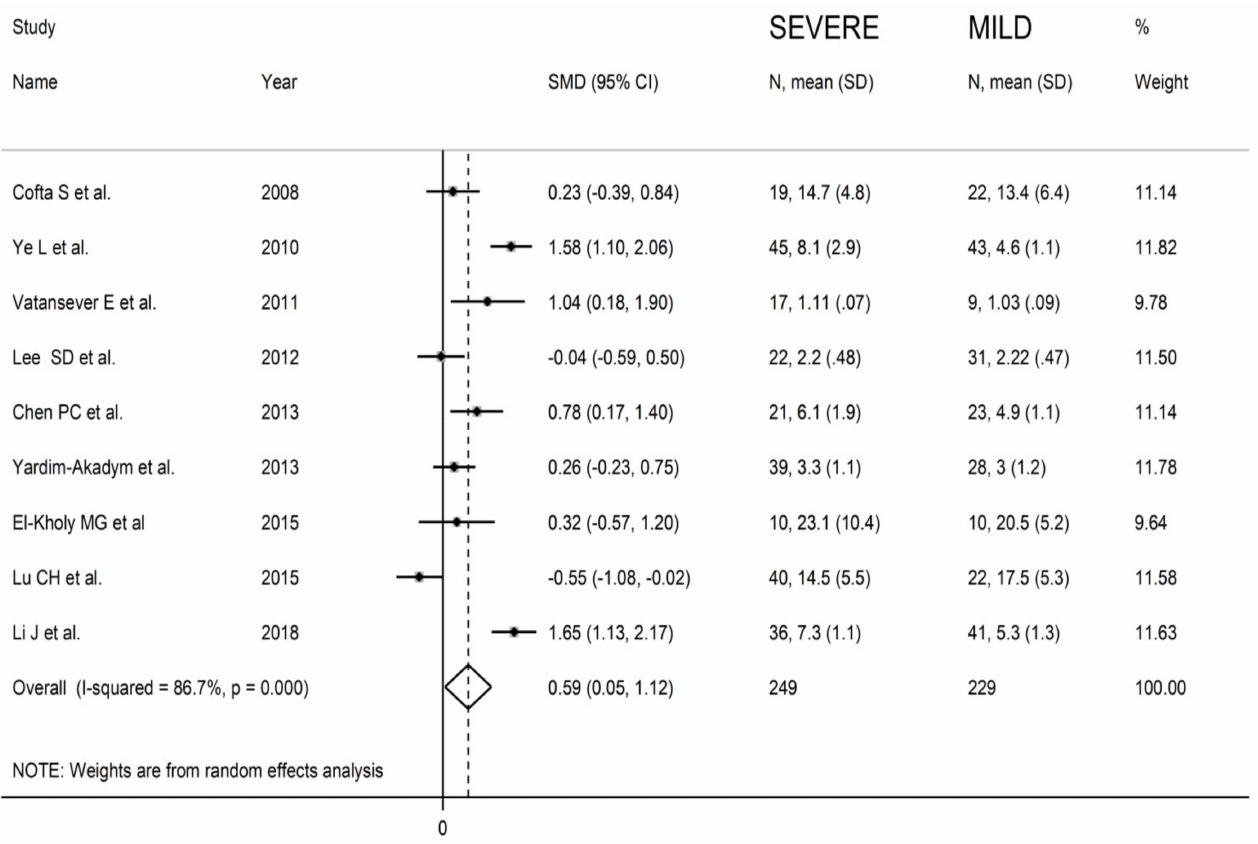
Figure 8. Forest plot of studies examining MDA concentrations in mild and severe OSA